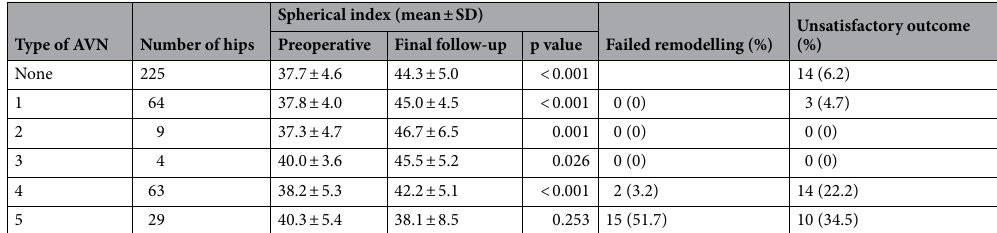
Table 6. Frequency of failed remodelling and unsatisfactory outcome in relation to the type of AVN. AVN avascular necrosis of the femoral head.